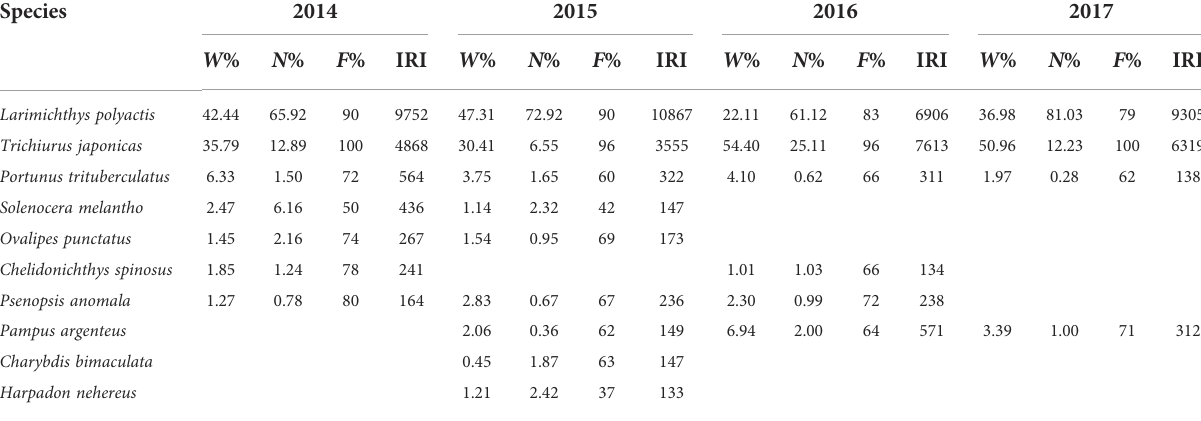
FIGURE 5 Diagram depicting taxonomic af fi liation, thermal preference, and feeding function of the species number associated with each group. TP, thermal preference; FG, function group; Cep, cephalopods; WW, warm water; WT, warm temperature; CT, cold temperature; EU, eurythermic; FG1, planktivores; FG2, small omnivores; FG3, piscivores; FG4, benthivores/piscivores; FG5, benthivores; FG6, predatory fi sh; FG7, cephalopods; FG8, shrimp; FG9, crab.